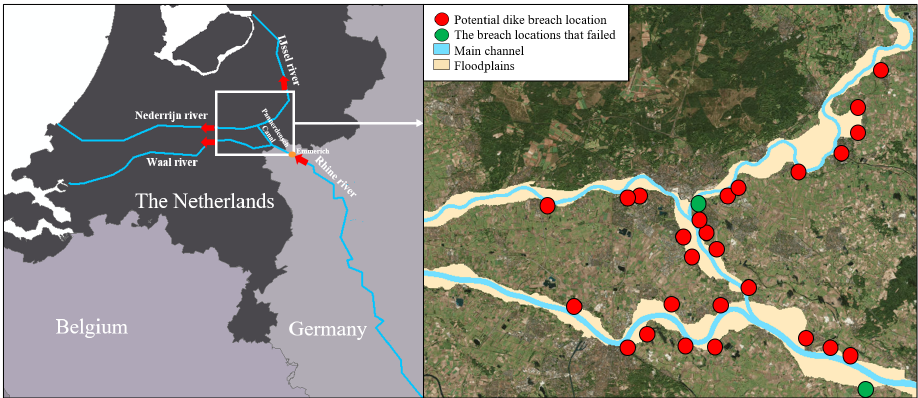
Figure 2. ( Left ) The Dutch Rhine river delta used as a case study. The red arrows indicate the flow direction; the orange dot indicates the location of the upstream model boundary (Emmerich, Germany). The Rhine river enters the Netherlands at the German–Dutch border. ( Right ) The potential dike breach locations included in the analysis. The red dots represent all potential dike breach locations considered in the hydraulic simulations, whereas the green dots represent the dike breach locations that failed during one or more of the hydraulic